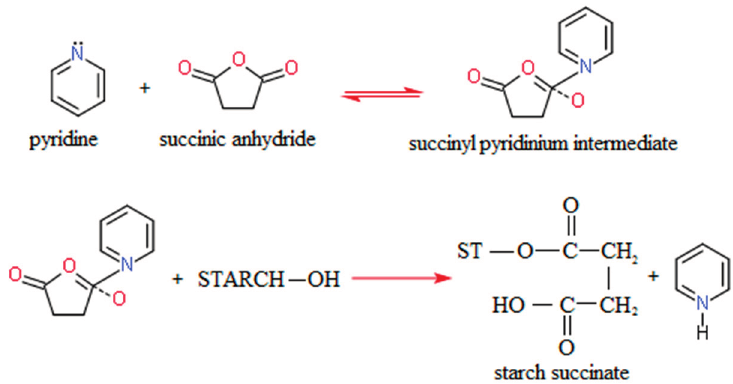
Figure 1. Modification of starch by succinylation